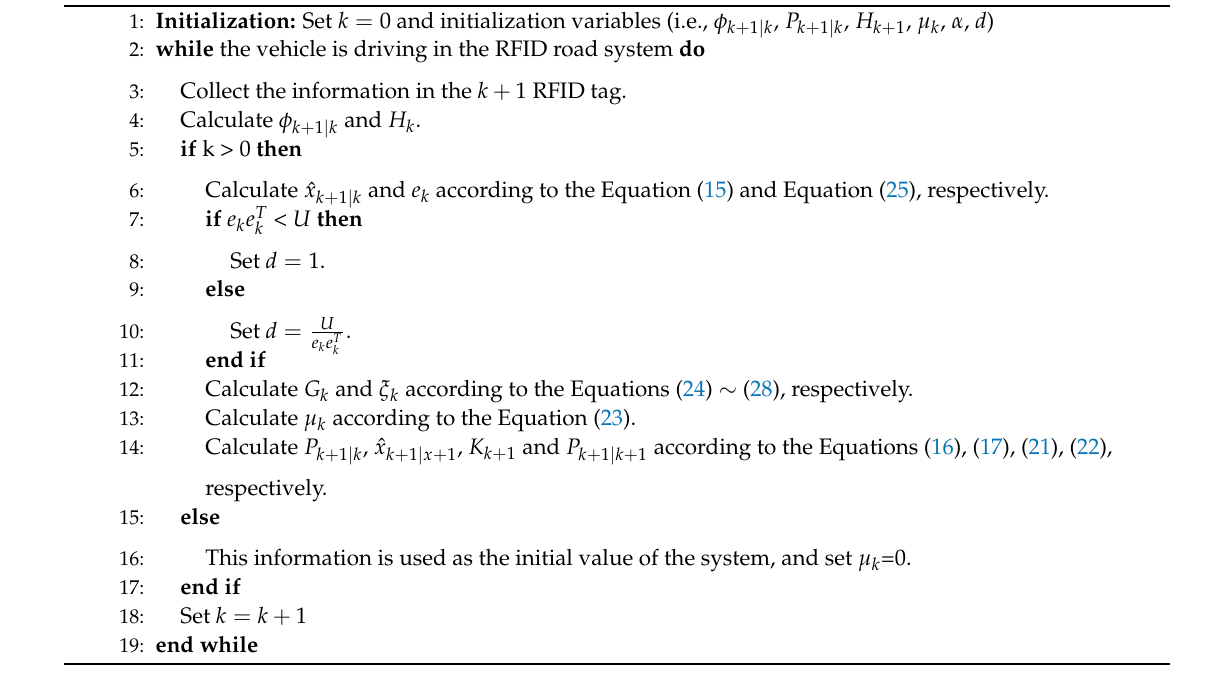
Algorithm 1. RFID data-driven speed prediction based on the AEKF